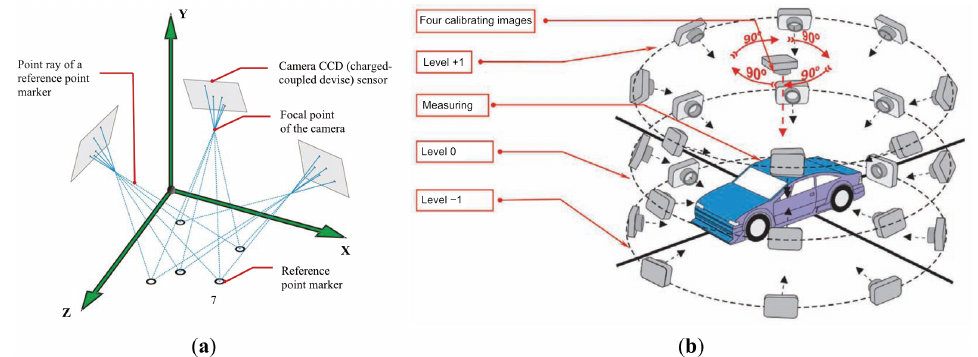
Figure 4. Principle of the photogrammetry method: ( a ) Beams of reference points in three images [19]. ( b ) Method of photographing large objects